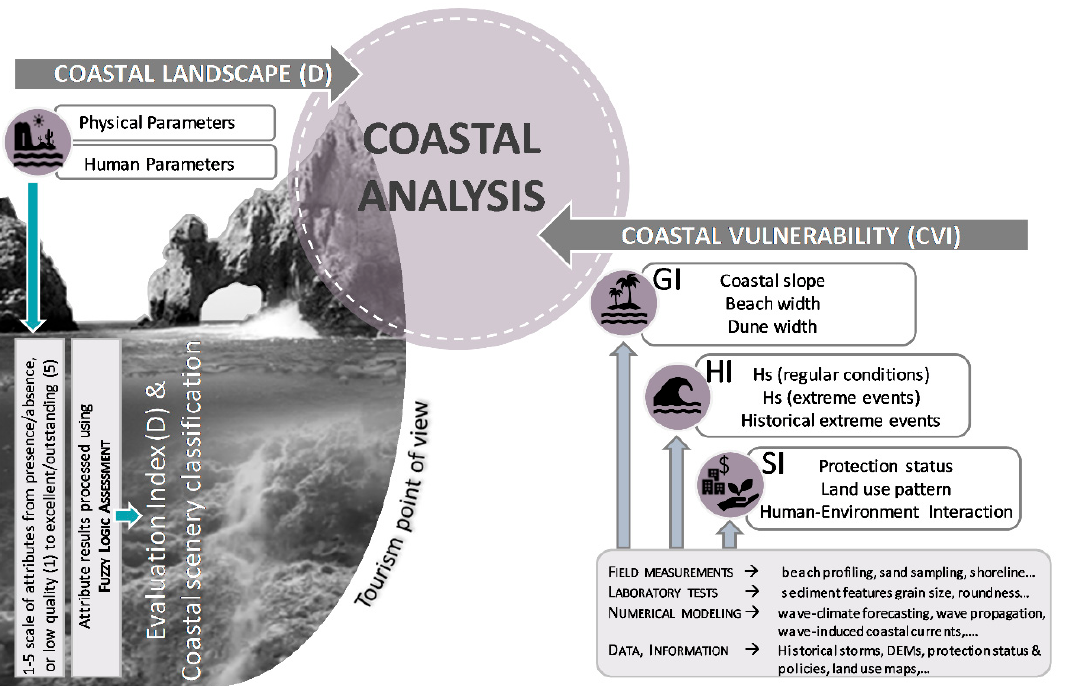
Figure 2. Methodology for the coastal analysis of vulnerability and landscape in Cabo San Lucas, based on geomorphological (GI), hydrodynamic (HI), and socioeconomic indicators for CVI, as well as on physical and human parameters for the Evaluation Index